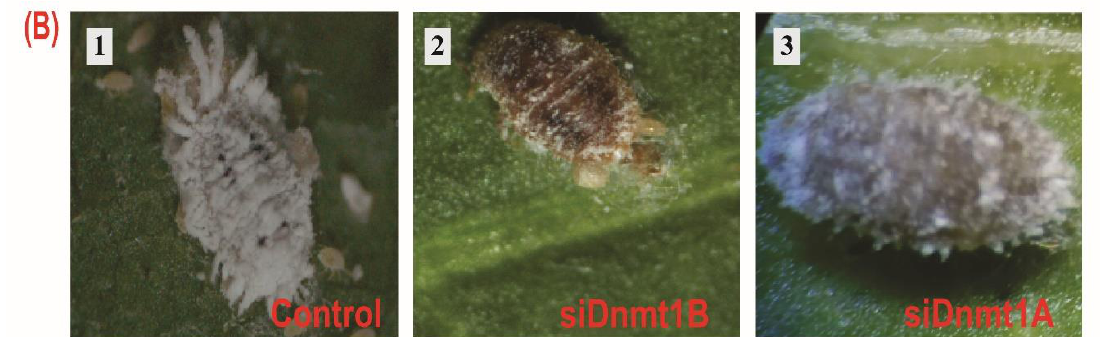
Figure 5. Abnormal phenotypes of survivors treated with siDnmt1A and 1B siRNAs. ( A 1) Newly molted pupa undergoing topical delivery with small interfering RNAs (siRNAs). ( A 2) Newly emerged adult male after 72 h post-treatment with a negative control with a single pair of well-developed wings. ( A 3) Newly emerged adult male after 72 h post-treatment with siDnmt1B with deformation wings. ( B ) Mortality in the o ff spring and abnormal color in adult females occurred in the adult females injected with siDnmt1A and 1B compared with the control. ( B 1) Adult gravid female with normal phenotype after injection with negative control. ( B 2,3) Adult gravid female with abnormal phenotype and dead o ff spring after 72 h post-treatment with siDnmt1B and siDnmt1A, respectively.